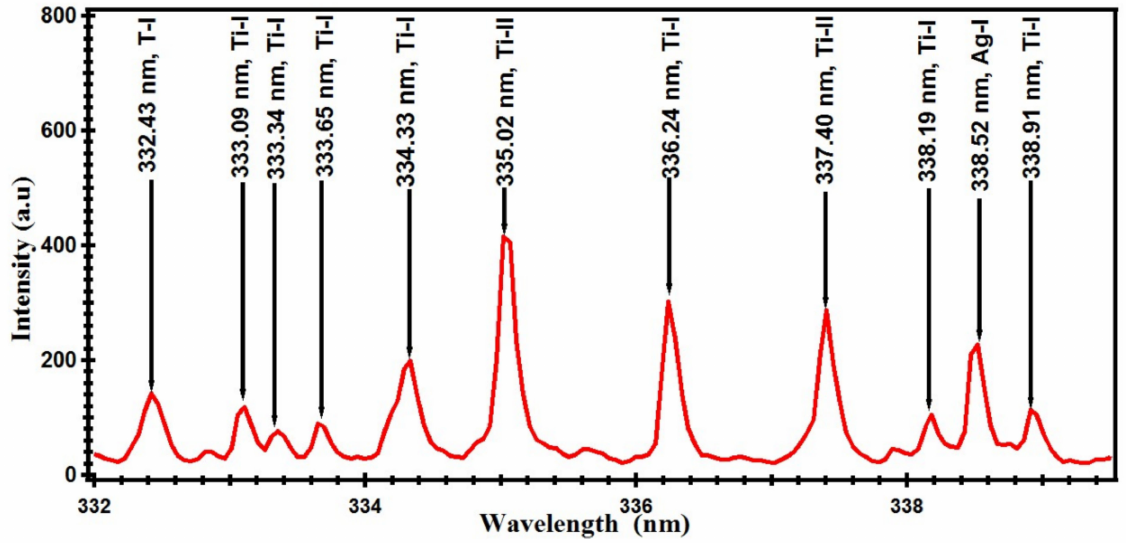
Figure 3. Optical emission spectrum of laser-produced astrophyllite plasma in the narrow spectral range of 330–340 nm. Table 1. Spectral lines of various elements as identified in emission spectrum of